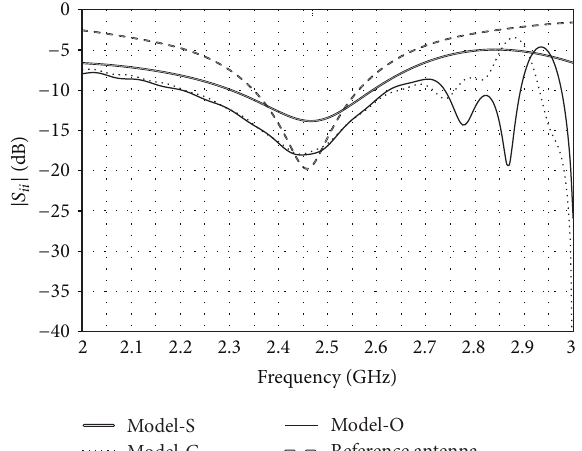
Figure 7: The reflection characteristics of the circular microstrip patch antenna with the AMC